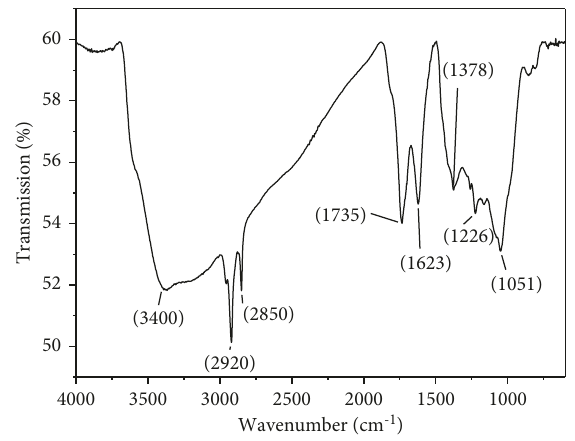
Figure 3: FT-IR spectra of Graphene oxide